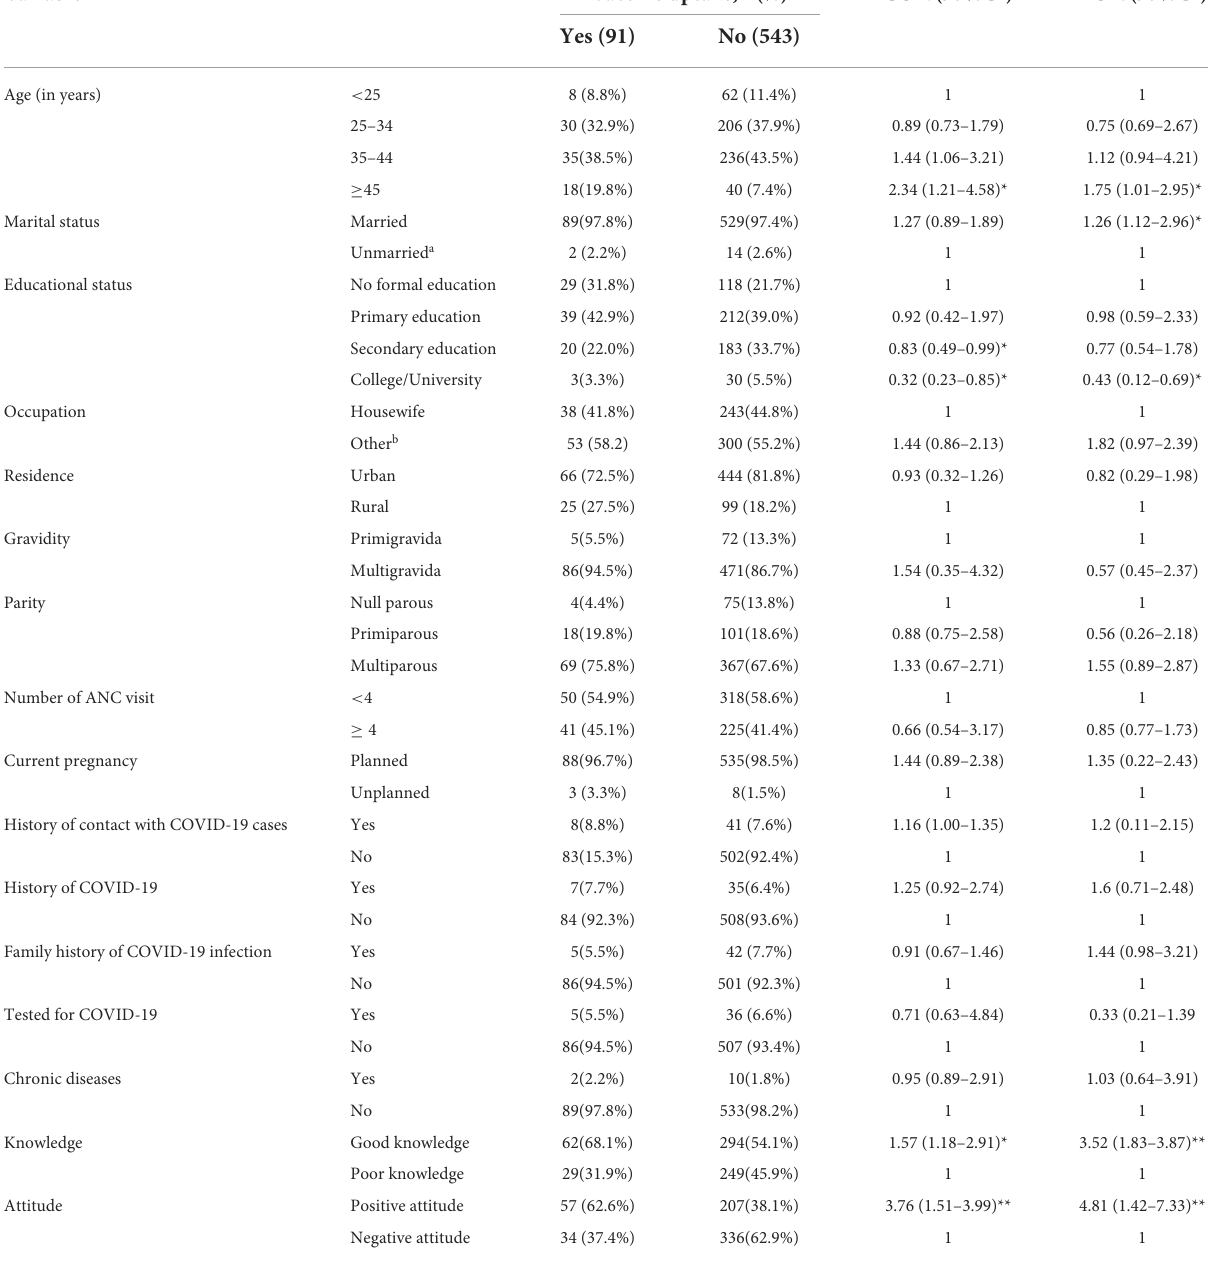
TABLE 3 Factors associated with COVID-19 vaccine uptake among pregnant women attending antenatal care in Debre Tabor public health institutions, Northwest Ethiopia,